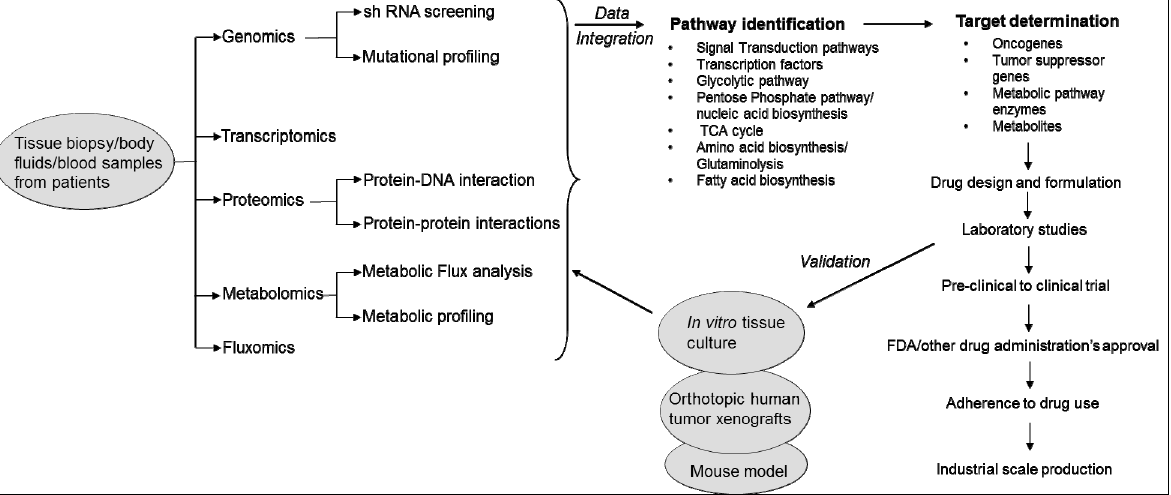
Figure 1. Systems biology approach to study cancer metabolism and identification of therapeutic